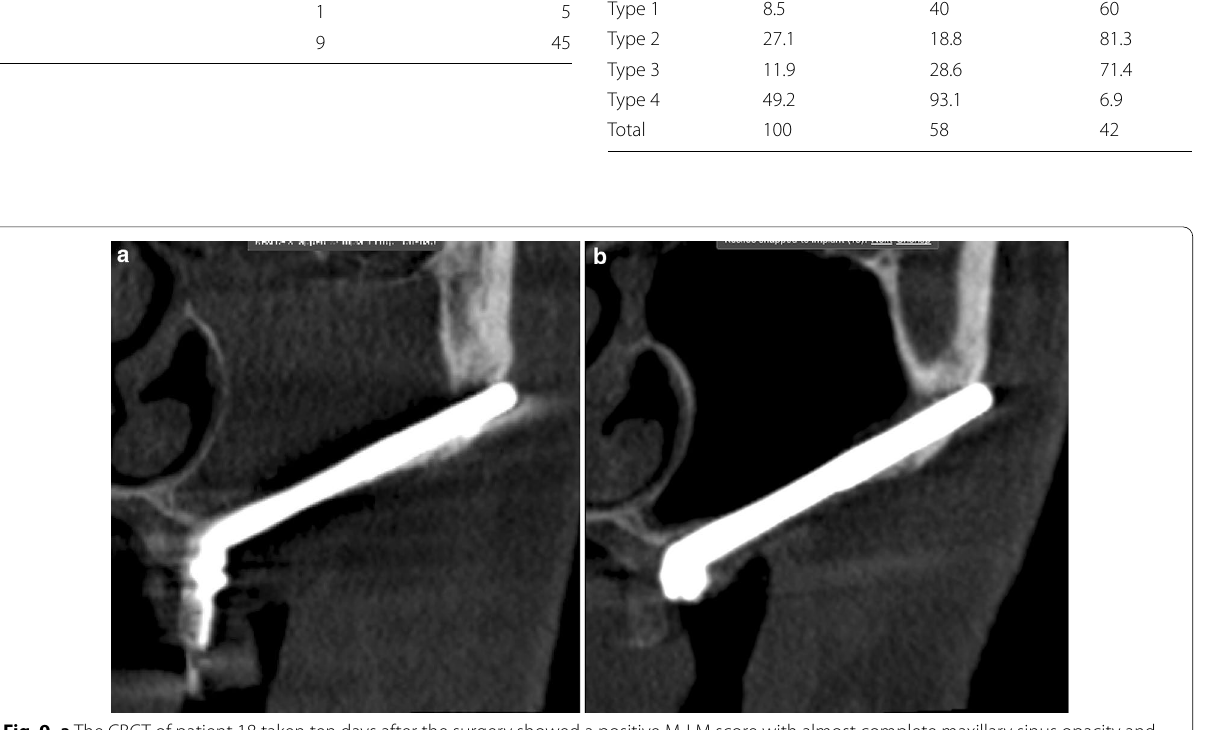
Table 4 Types of zygomatic implant rehabilitation Number of zygomatic implants used